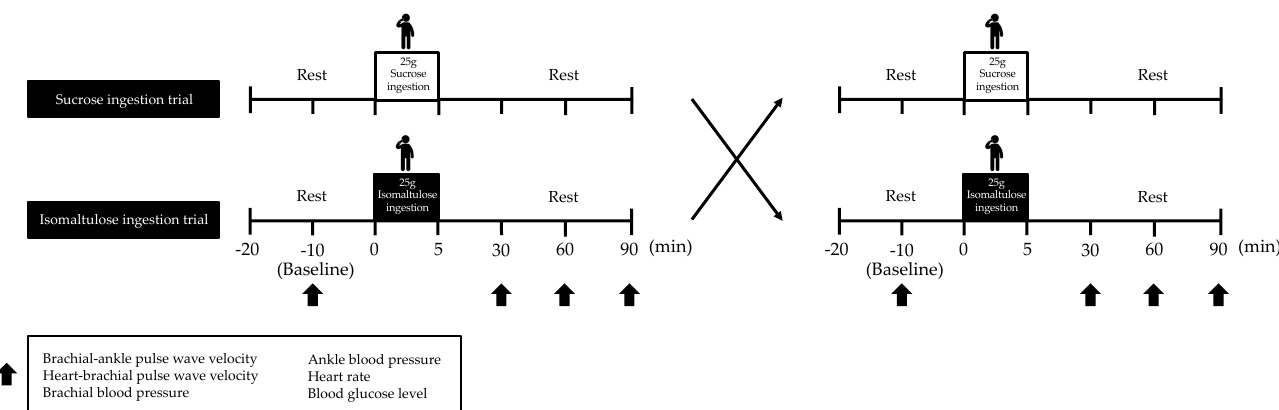
Figure 1. Study design. Arterial stiffness, BP, HR, and BG levels were measured at baseline and at 30, 60, and 90 min after isomaltulose or sucrose ingestion. The participants rested in a supine position for 10 min before the test. BP, blood pressure; HR, heart rate; BG, blood